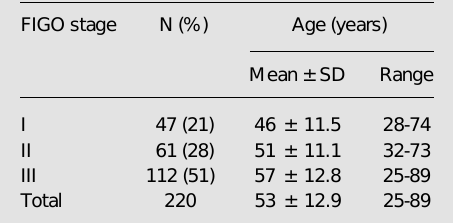
Table 1. Distribution of the patients with cervical squamous cell carcinoma according to FIGO stage and age. FIGO